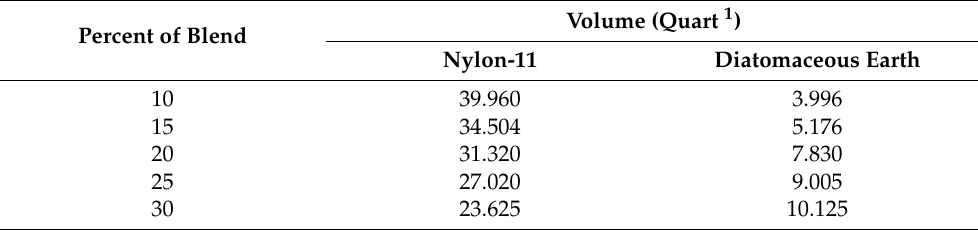
Table 3. Percent of blends by volume of nylon-11 and diatomaceous earth. Volume (Quart 1 ) Percent of Blend Nylon-11 Diatomaceous Earth